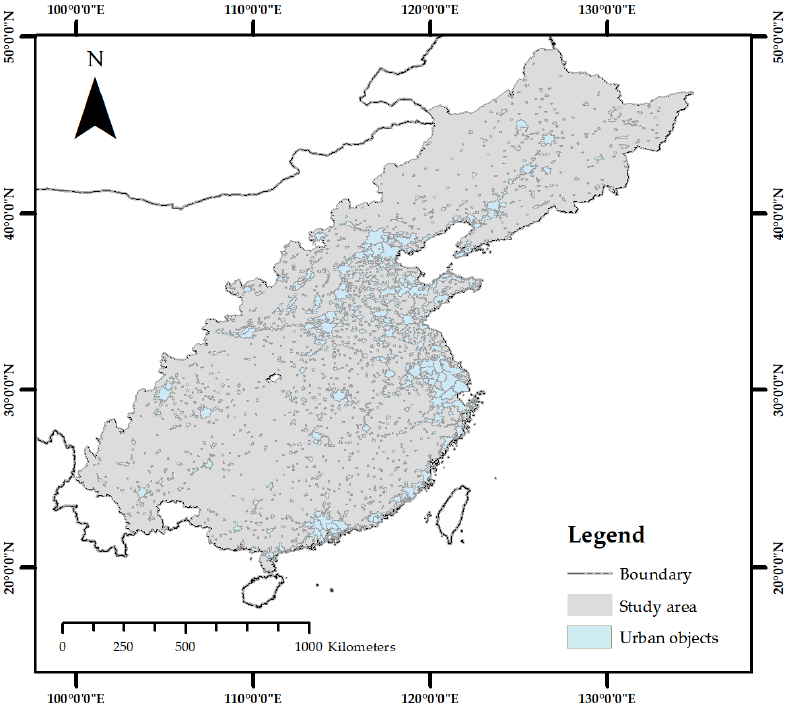
Figure 7. The urban objects.